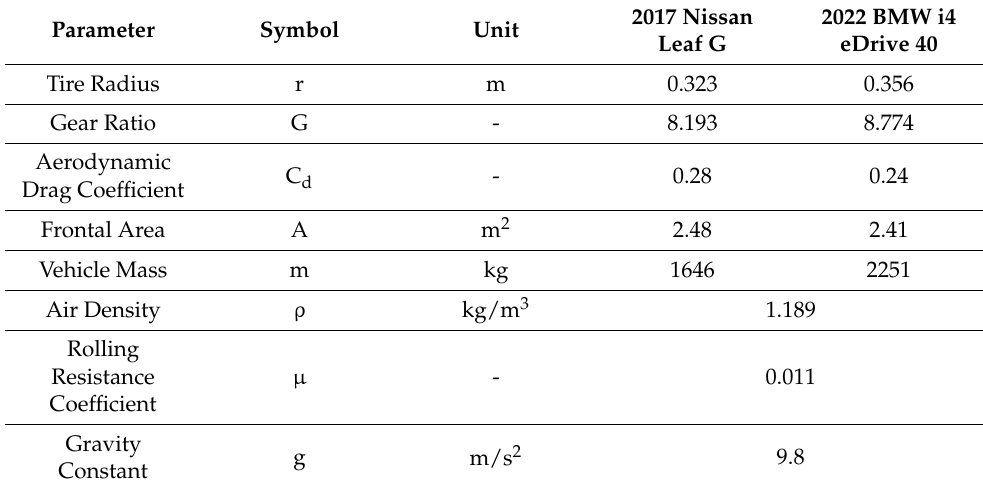
Table 2. Parameters of test vehicles.